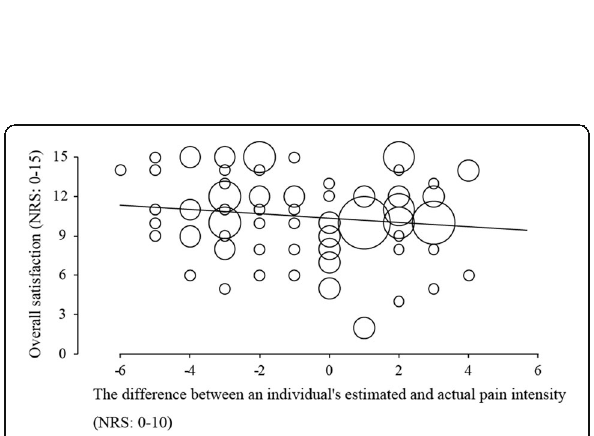
(Fig. 3; Spearman r = − 0.136, p = 0.194).